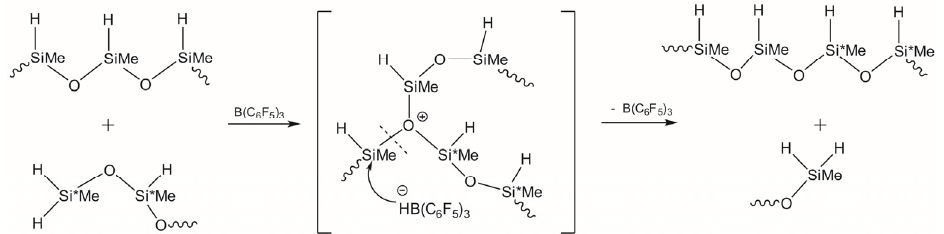
Scheme 2. Chain scrambling reaction.